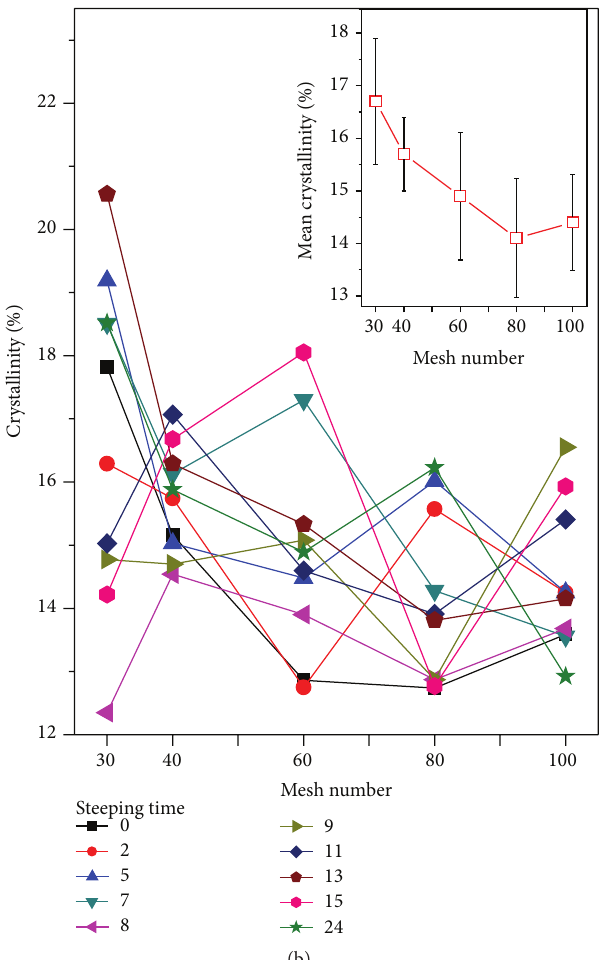
Figure 4: (a) X-ray diffractograms of the PSD samples for different ST. (b) The crystallinity of the PSD samples versus the mesh numbers chosen, for the different ST values, selected for the study. The inset displays the mean crystallinity, averaged on the twelve ST values, against the mesh